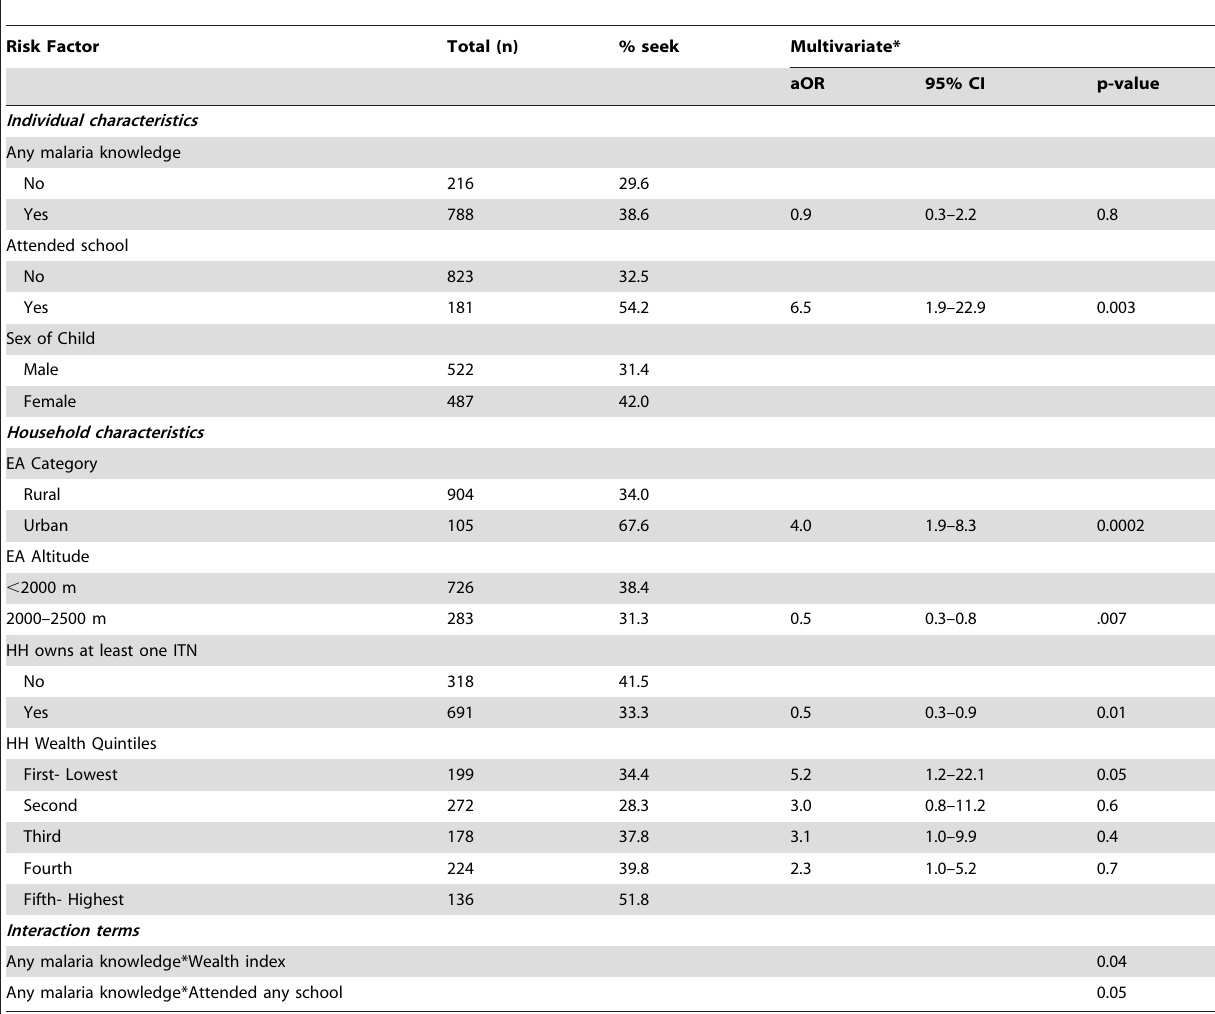
Table 7. Knowledge of malaria amongst mothers of children U5 as it predicts access to fever treatment for their children U5 with reported fever in the past two